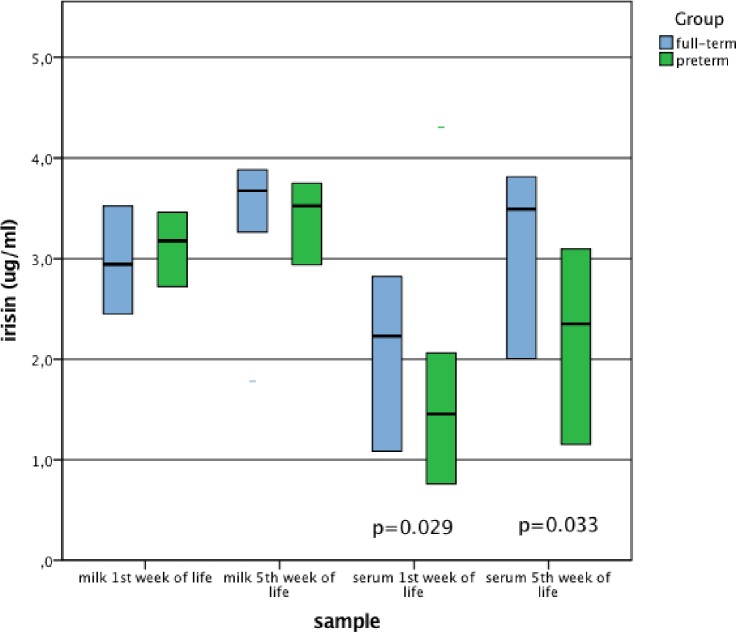
Comparison of milk and serum irisin concentrations in the groups of full-term and preterm newborns.Data are presented as median and interquartile range, P-values for U Mann-Whitney test.